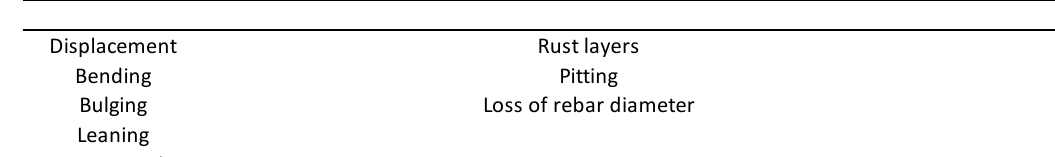
Figure 3. Types of damage classified in eight groups as defined in MDCS.